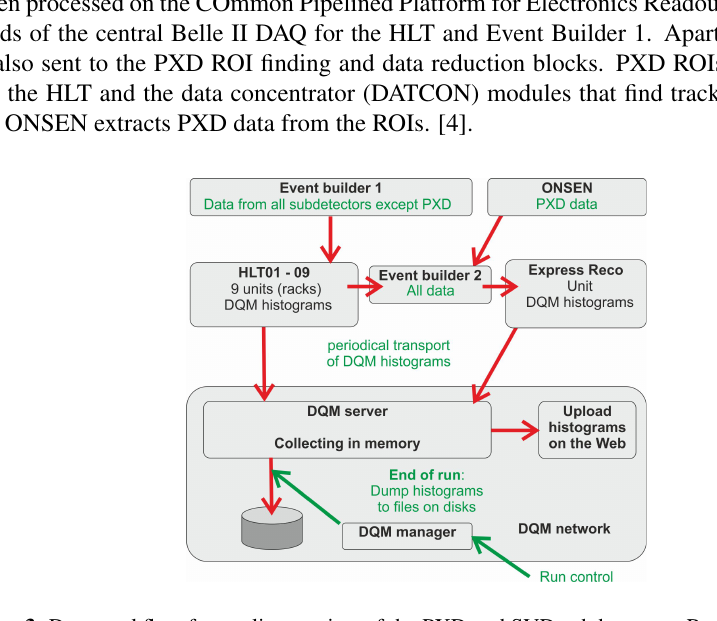
Figure 3. Data workflow for quality monitor of the PXD and SVD subdetectors. Red arrows represent data flows, green markings represent